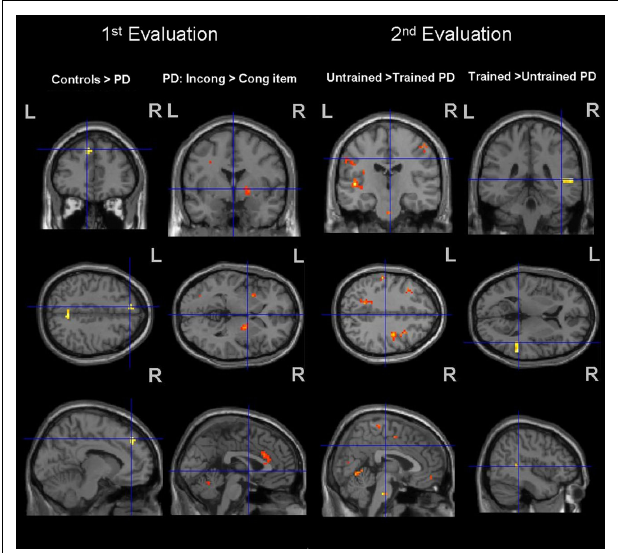
FIGURE 4 | Brain activation as evident in the SPM comparative analysis. Anatomically defined marks were used to display the activation in the regions of interest (ROIs) using theTalairach andTournoux (1988) atlas tool in SPM2.The results are shown for: (i) the first evaluation (the first two columns on the left): control group > PD at solving incongruent items, and PD patients at solving incongruent items; the second evaluation (the first two columns on the right), trained with respect to untrained patients and untrained with respect to trained patients.There is a different pattern of activation between both groups that reflects the effect of the training